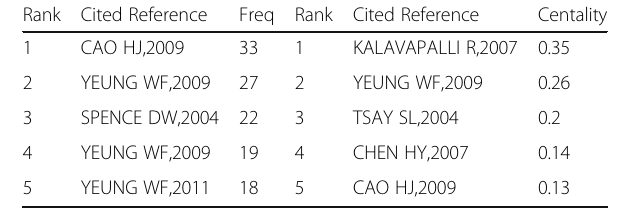
Table 5 Top 5 cited reference related to acupuncture